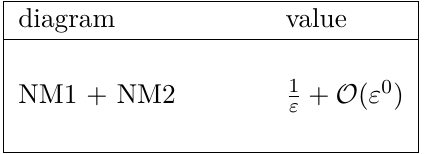
2 S (¯ x t − ¯ y t ) 0 (4 π ) 2